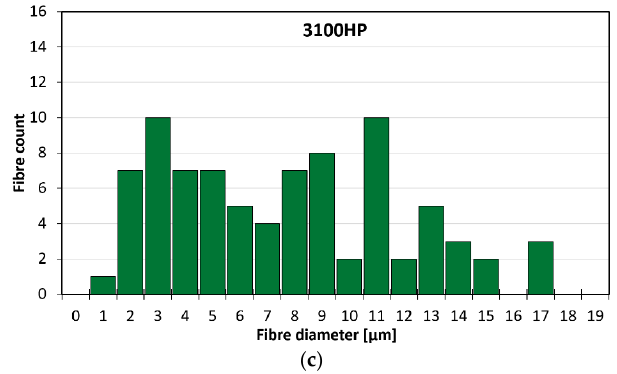
Figure 3. Diameter distribution of fibres obtained from 3052D ( a ), 3001D ( b ) and 3100HP ( c ) grade PLA.